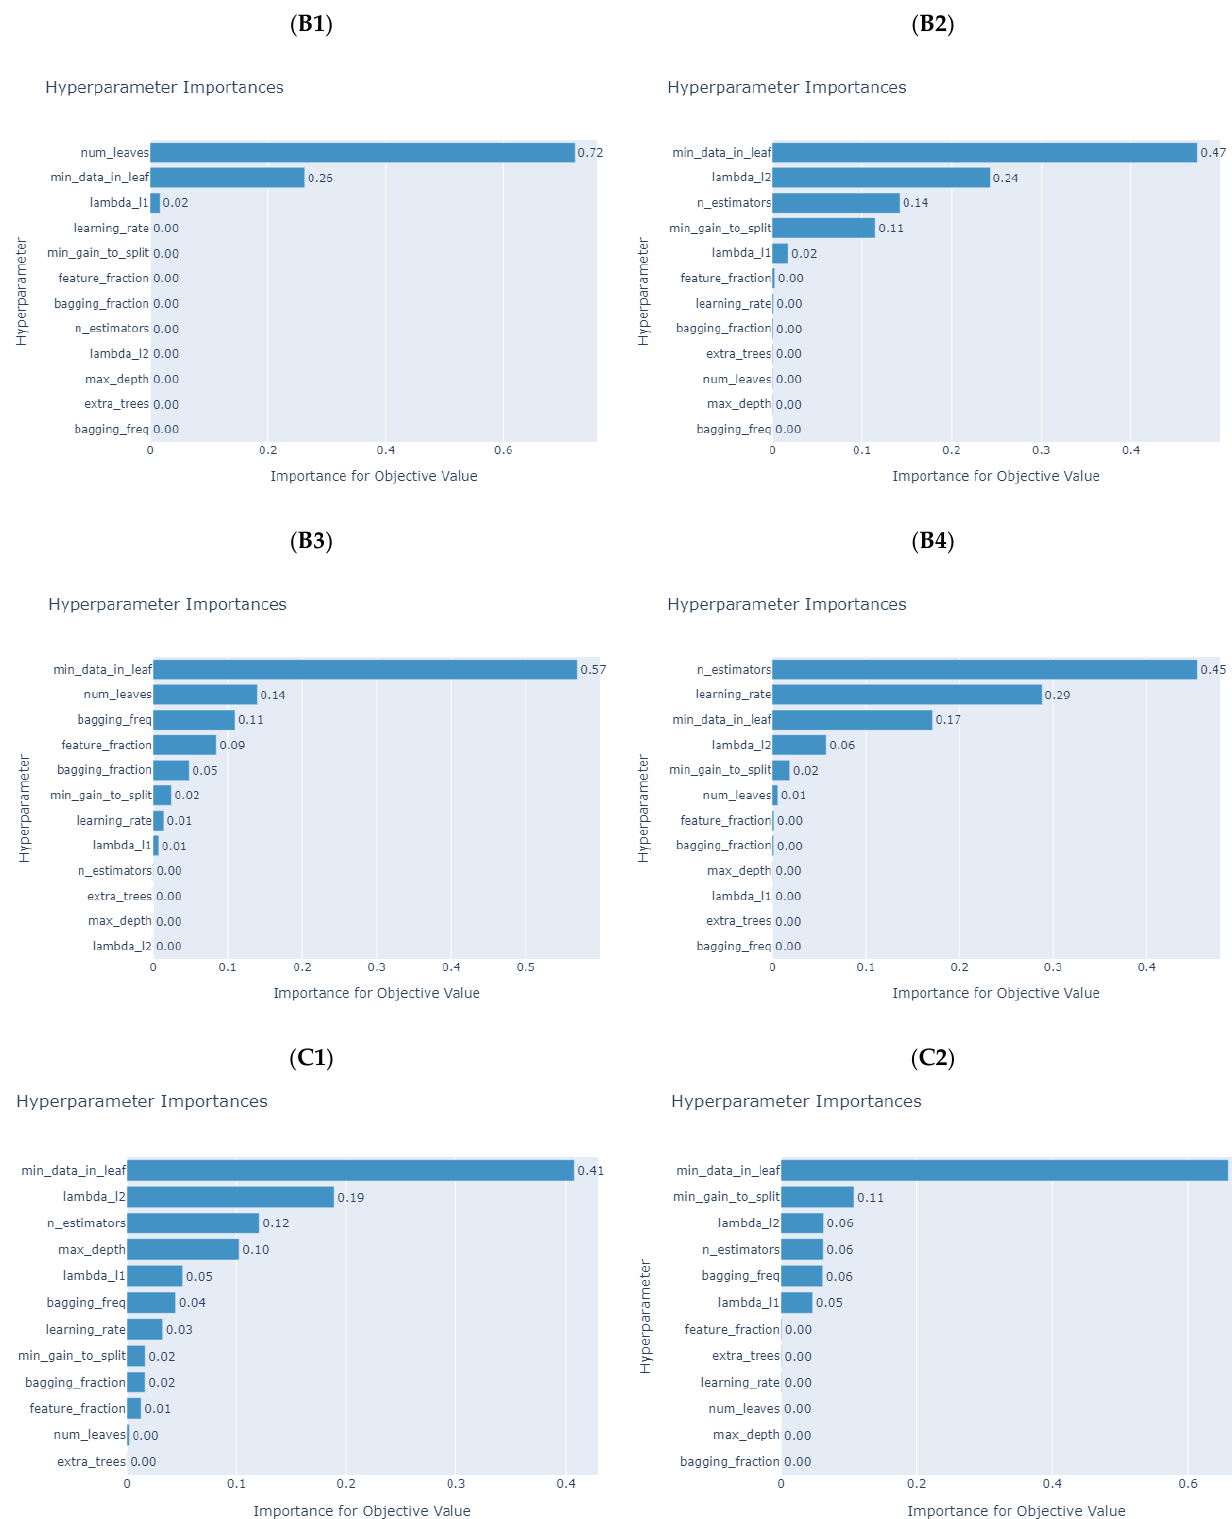
Figure 5. Hyperparameter importance of LightGBM models for product category A (product A1 – A6).